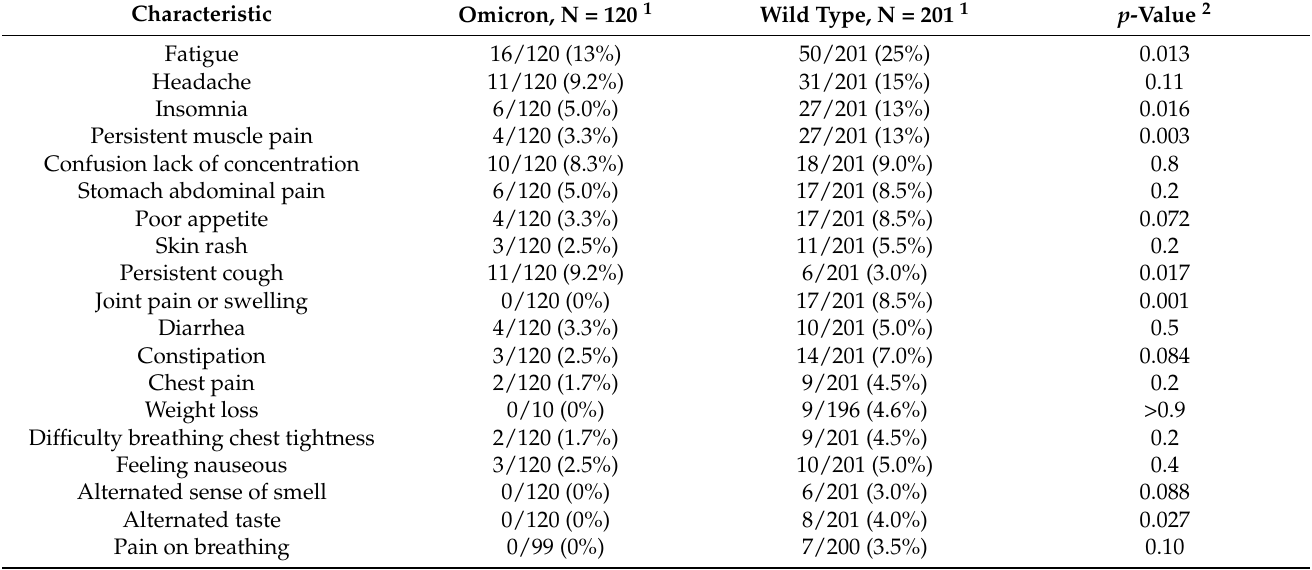
Table 3. Persistent symptoms comparing Omicron and original variants at 1-5 months’ follow-up. Only the children followed up within the same time period were included.